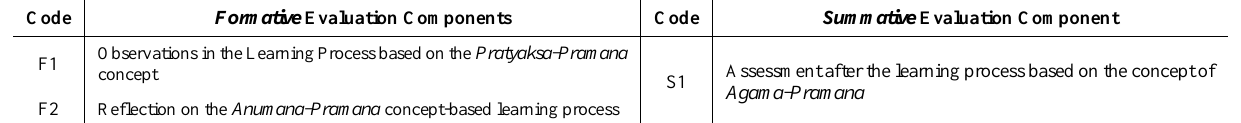
Table 2. Standard Components of Tri Pramana -Based Formative-Summative Evaluation